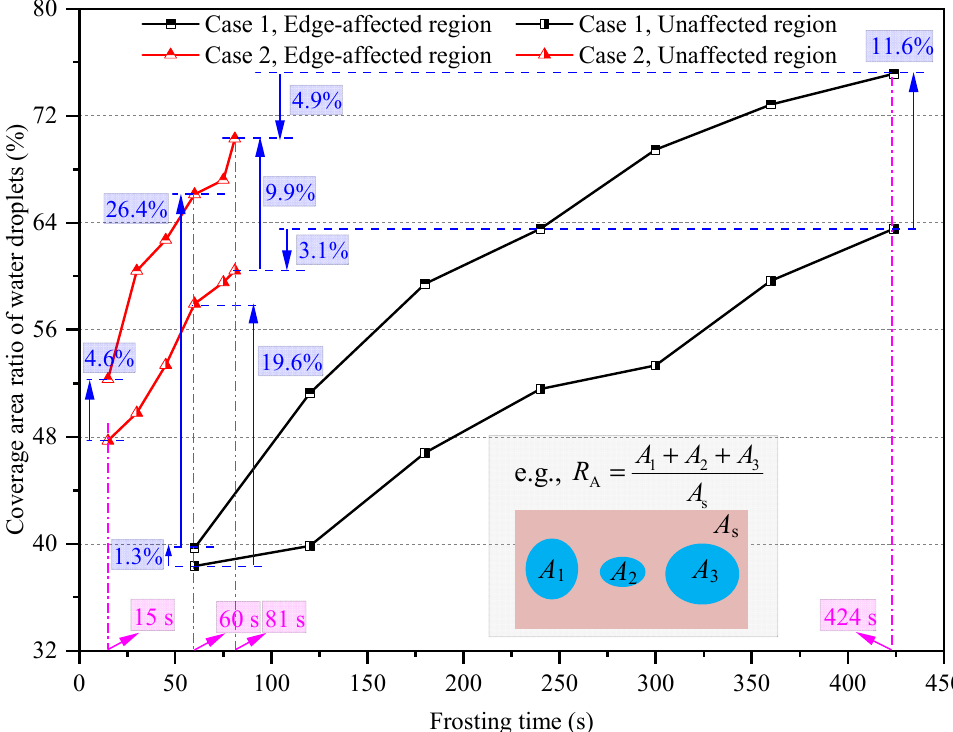
Figure 6. The coverage area ratio of water droplets in edge-affected and unaffected regions. Considering the area of the edge-affected region was closely related to the length of the field of view and its shape was not regular, a parameter defined as the equivalent width of the edge-affected region was employed, as presented in Figure 7. The equivalent width of the edge-affected region was used to represent the effective range impacted by the edge effect. As seen, the equivalent width of the edge-affected region consistently increased as time passed and was notably affected by air velocity. At 60 s, the equivalent width of the edge-affected region in Case 2 was 131.9 × 10 − 6 m/s, which was 1.51 times greater than in Case 1. As time passed, the equivalent width of the edge-affected region in Cases 1 and 2 were 145.5 × 10 − 6 and 173.6 × 10 − 6 m/s at 424 and 81 s, respectively. It can be found that the equivalent width of the edge-affected region in Case 2 was only 19.3% greater than in Case 1 at the end of their respective WDC stages because the WDC stage duration in Case 1 was notably longer than in Case 2.